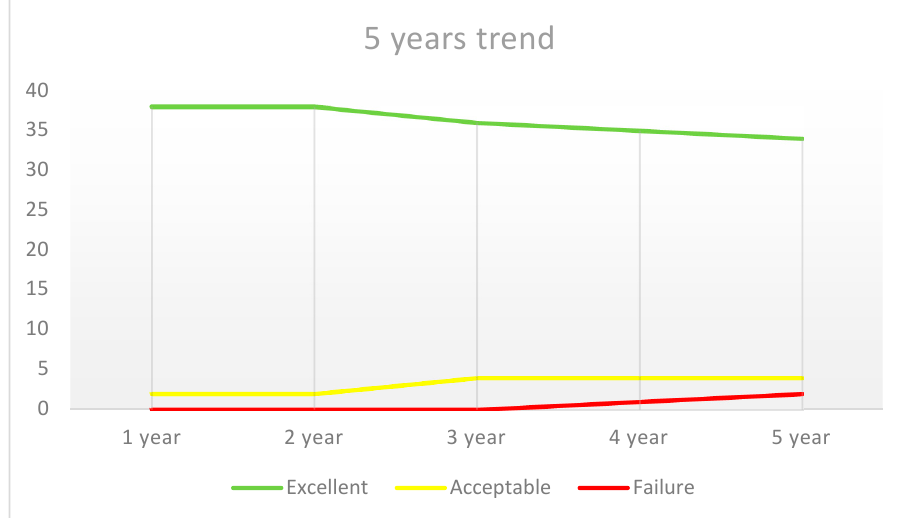
Figure 5. Five-year outcomes trend.